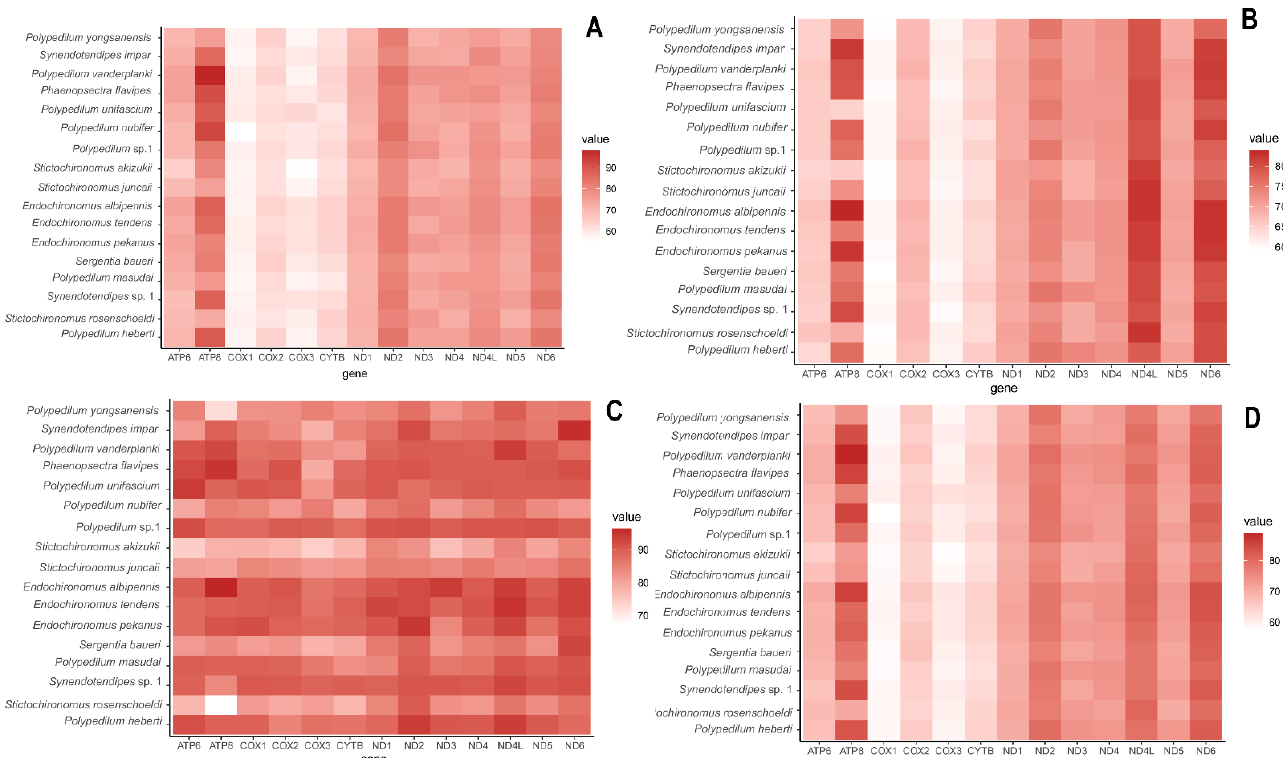
Figure 2. Difference in AT content of protein coding genes of Polypedilum generic complex mitogenomes. ( A ) First-codon positions; ( B ) second-codon positions; ( C ) third-codon positions; ( D ) first/second-codon positions.